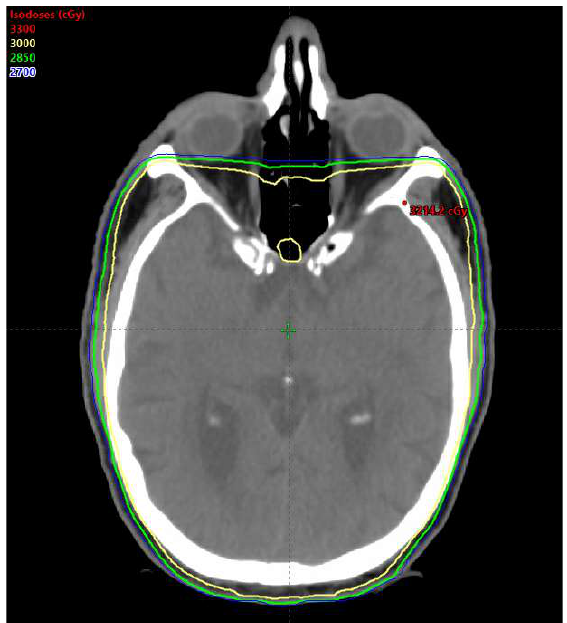
Figure 2. A radiation treatment plan in a patient with multiple brain metastases receiving whole brain radiation therapy to a dose of 30 Gy.